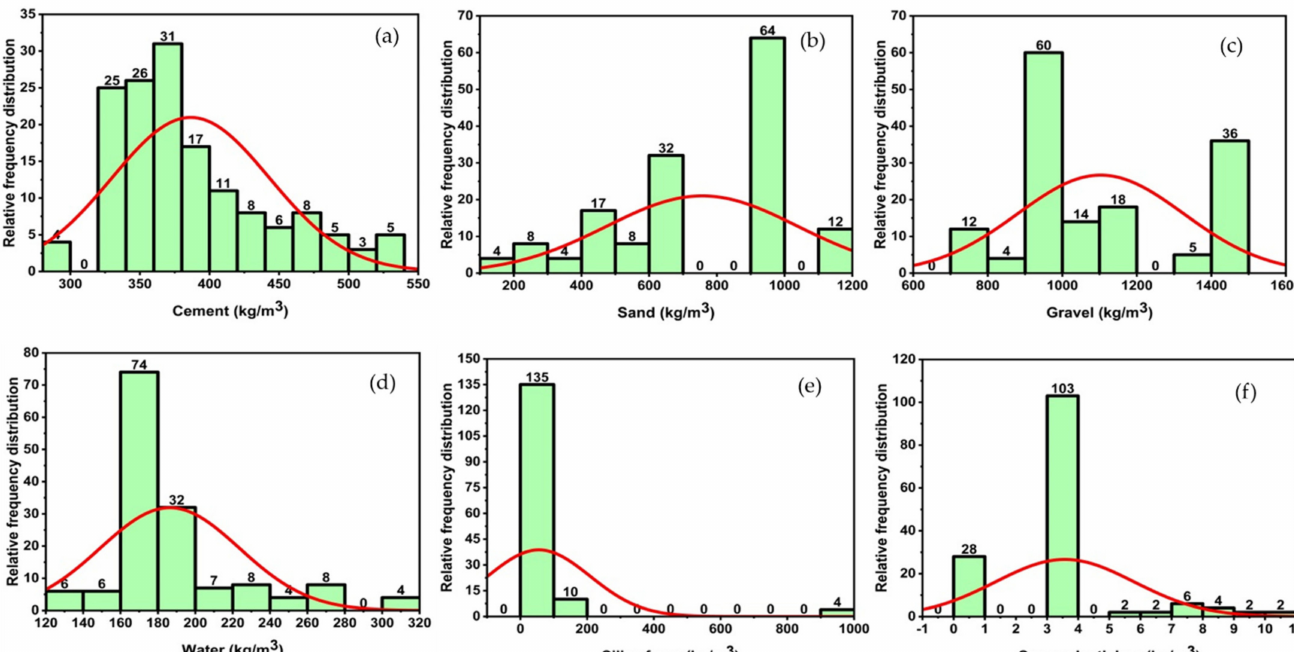
Figure 7. Relative frequency distribution of parameters to tensile strength; ( a ) cement, ( b ) sand, ( c ) gravel, ( d ) water, ( e ) silica fume, ( f ) super